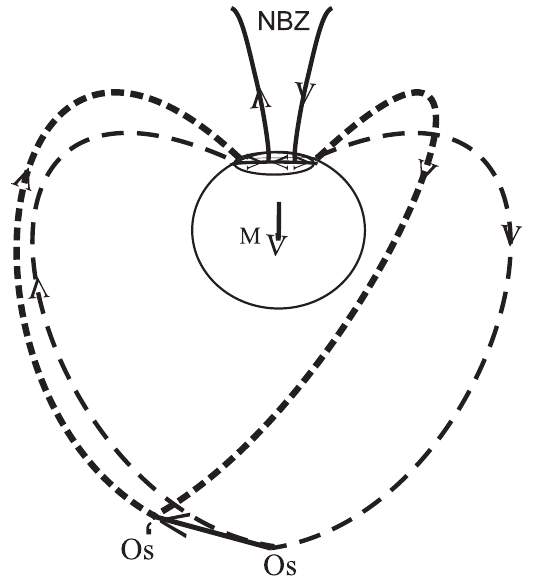
Fig. 3. Scheme of the northern transition current system. textbfM is the Earth’s dipole. NBZ currents flowing into the ionosphere in the dusk, flow then on the ionosphere as the Pedersen currents, which are closed later by the field-aligned Region 1 currents flowing out from the northern ionospheric open field line boundary (marked by a circle) to the southern neutral point ( O s for the IMF with B x = 0, 0 6= 0, B y 6= 0, and B y = 0, and B z > 0, and O s for the IMF with B x B z > 0). Then they flow from the southern neutral point along field lines going to the dawn open field line boundary of the northern po- lar cap. After that they flow as the Pedersen ionospheric currents, and later are closed by the NBZ field-aligned currents flowing out from the northern ionosphere. Field-aligned currents for zero (non- zero) IMF B x and B y components are marked by the dashed (dot- ted)